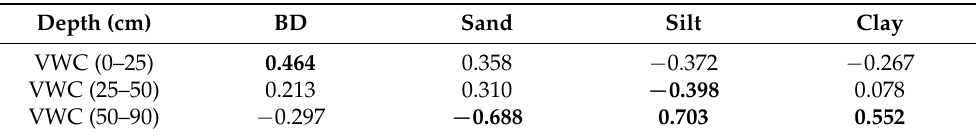
Table 2. Correlation between VWC and BD, Sand, Silt, and Clay at different soil layers. Significant ( p < 0.05) Pearson’s r is reported in bold.